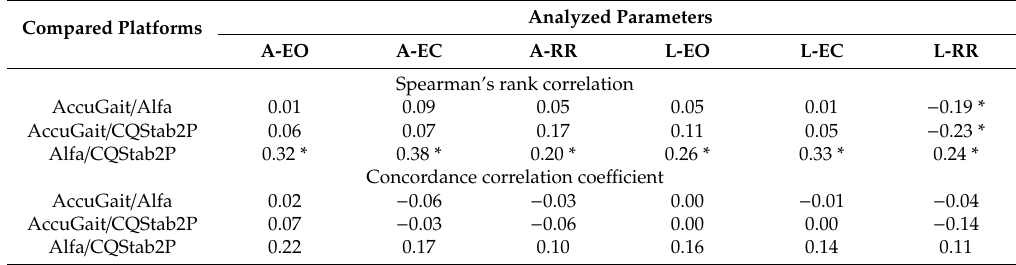
Table 2. Results of the correlation tests for the compared platforms for all of the analyzed parameters. Compared Platforms